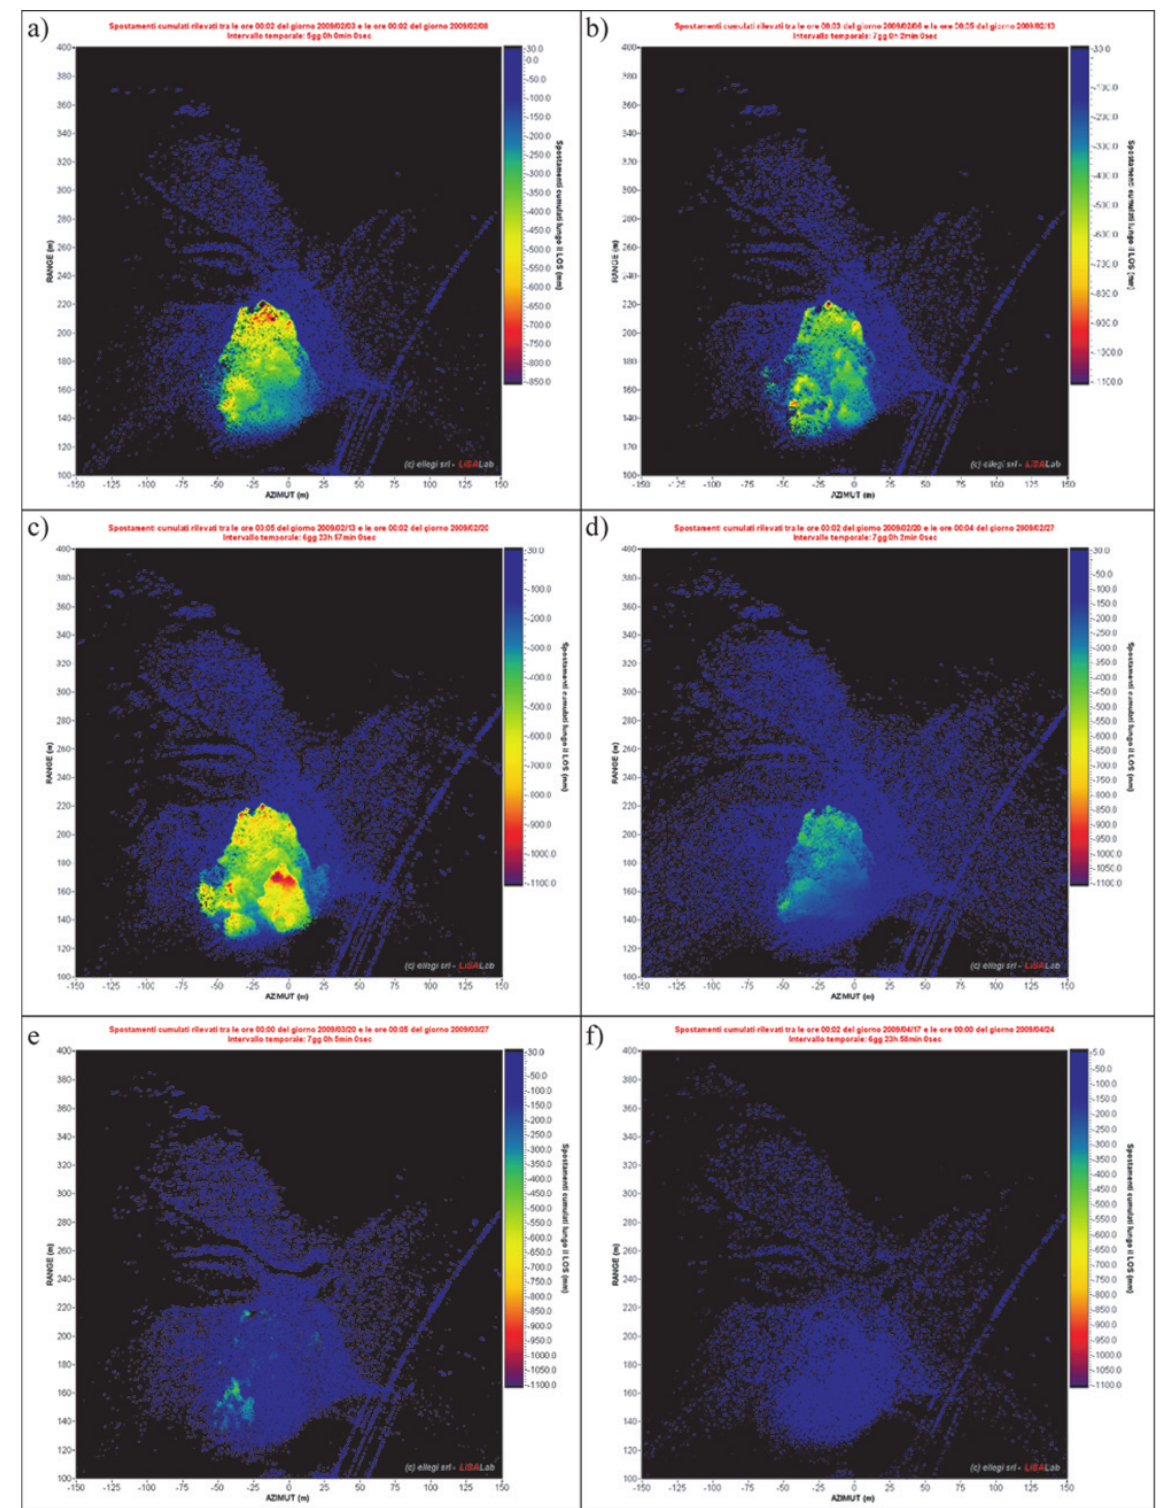
Fig. 9. Cumulative displacement maps that cover the entire time span of the monitoring campaign. The elapsed time for each of them is: (a) 02/02/09–09/02/09; (b) 06/02/09–13/02/09; (c) 13/02/09–20/02/09; (d) 20/02/09–27/02/09; (e) 20/03/09–27/03/09; (f) 17/04/09– 24/04/09. Note that the chromatic scale is not the same among all the